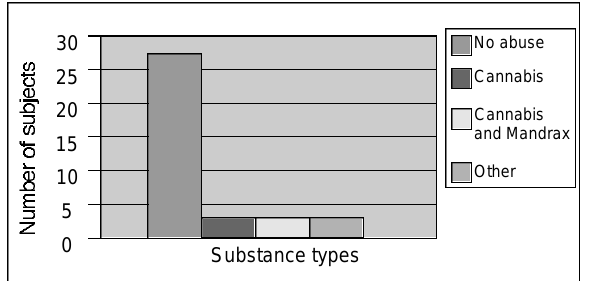
Fig. 1. Substances preferred by cont rol group.